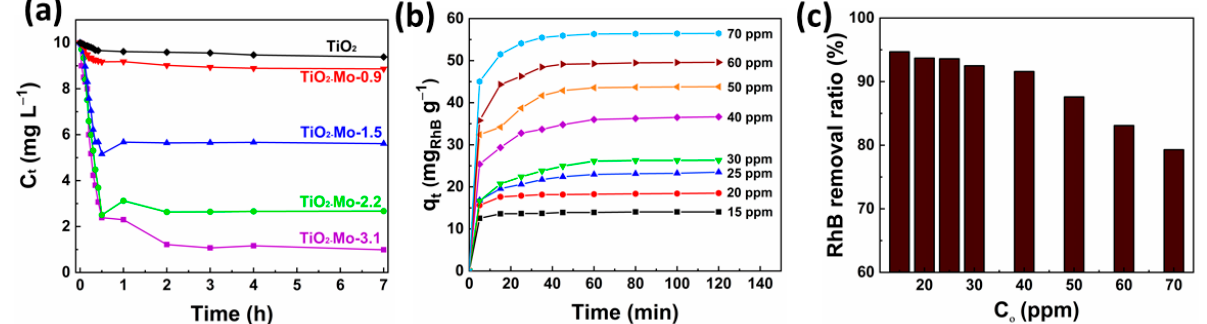
Figure 7. ( a ) Effect of contact time on the adsorption of RhB on different adsorbents ( C o = 10 mg L − 1 , temperature = 298 K), ( b ) Effect of initial concentration and contact time on the adsorption of RhB on TiO 2 -Mo-3.1 at 293 K, and ( c ) Effect of the initial concentration on the removal efficiency of RhB at 293 K.